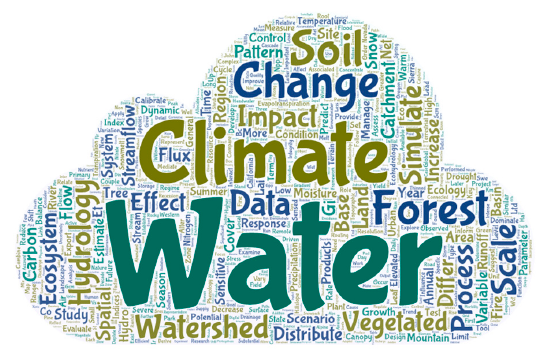
Figure 4. Topic words of RHESSys-related papers . Note: Extracted topic words are based on the collected 90 papers (title, abstract, and keyword). The font size is proportional to the relative frequency of each word; a word with larger font represents more frequently occurring in papers; colors are for distinguishing between different words.